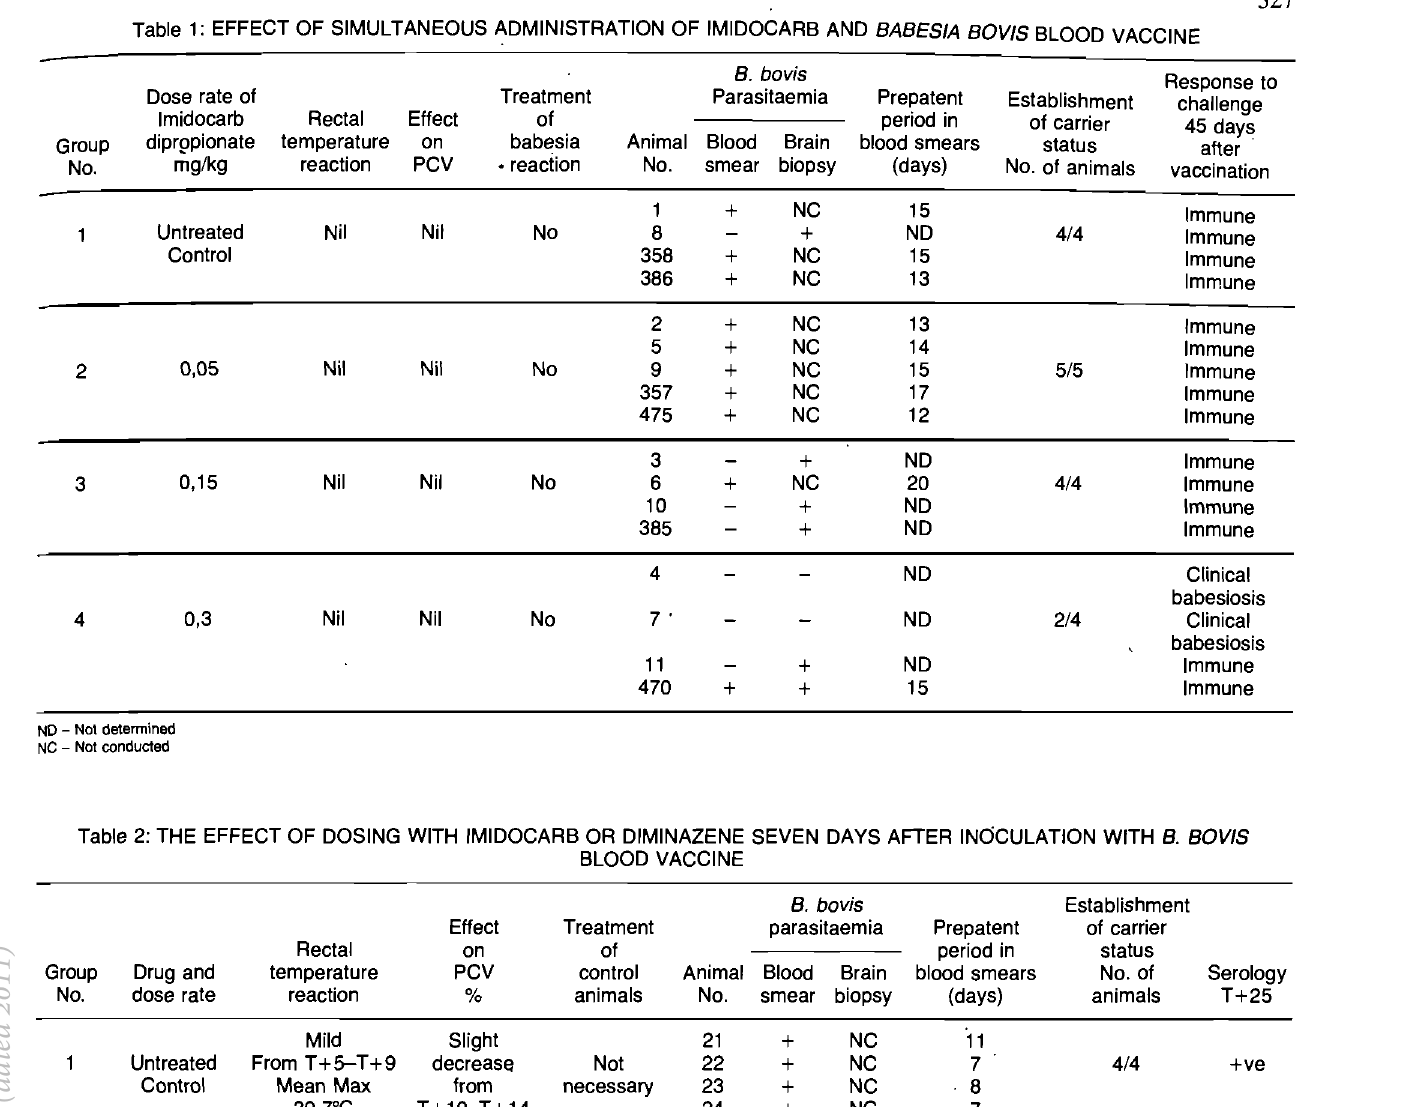
Table 1: EFFECT OF SIMULTANEOUS ADMINISTRATION OF IMIDOCARB AND BABESIA BOVIS BLOOD VACCINE